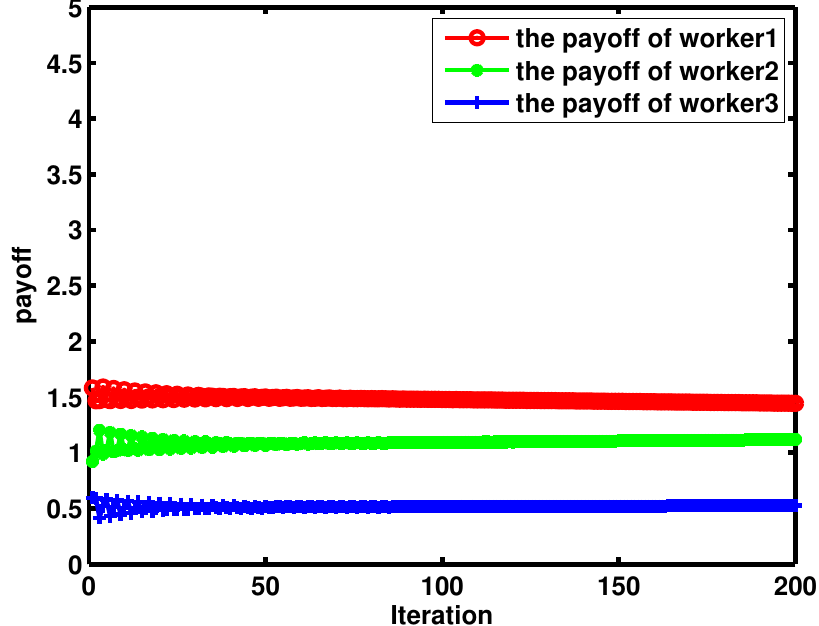
Figure 1. The payoff of 3 workers where worker 1 uses the ZD1 strategies.